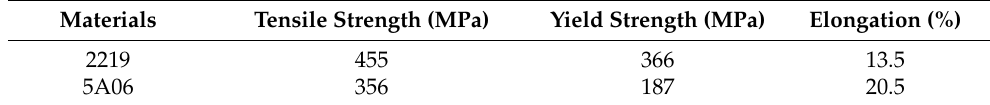
Table 2. Mechanical properties of base materials used in this